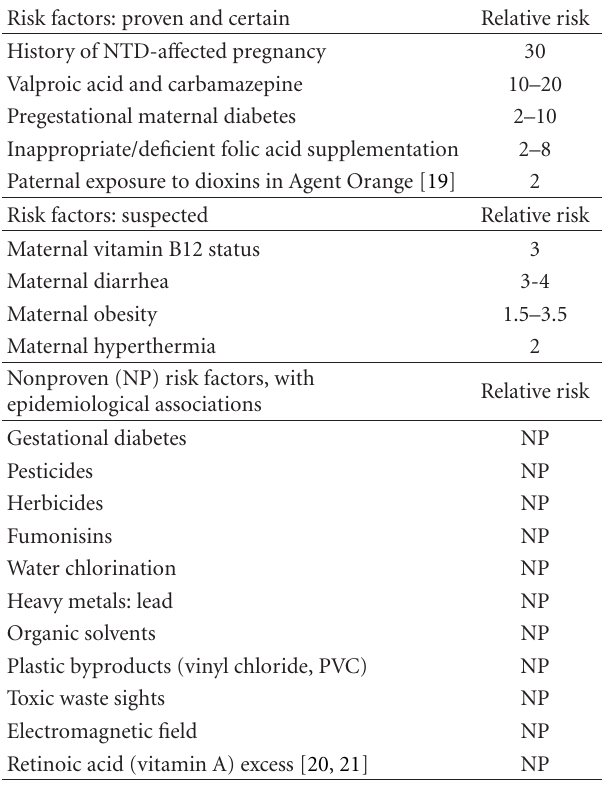
Table 1: Proven and suspected risk factors for spina bifida (NP = not